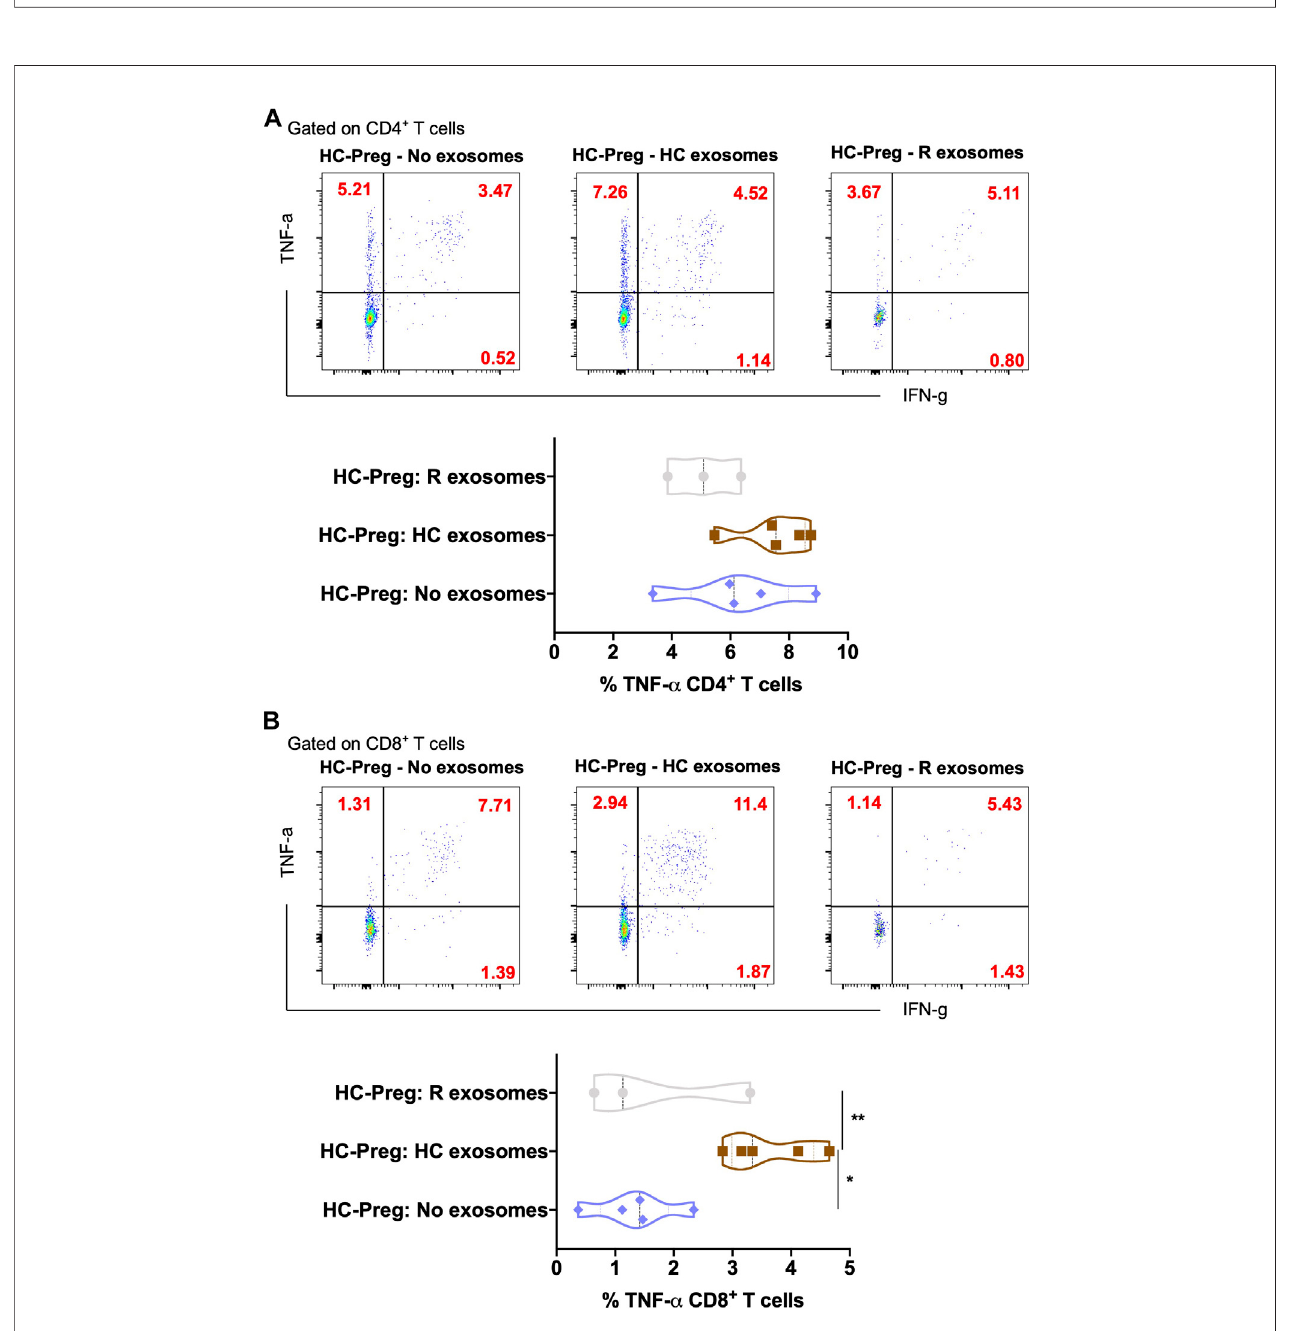
FIGURE 1 | bead populations by their fl uorescence in the FITC vs . PE channel with adjunct dot plots showing respective APC-stained bead populations: Buffer control vs . pregnant healthy and control vs. pregnant COVID-19-recovered samples. (D) Representative quanti fi cation of the MFI values of exosome levels using speci fi c exosome antibody-coated bead populations between pregnant healthy control ( n = 7) and pregnant COVID-19-recovered samples ( n = 3). p-value shows statistical signi fi cance among control and pregnant COVID-19-recovered samples, * p < 0.05, ** p < 0.01.